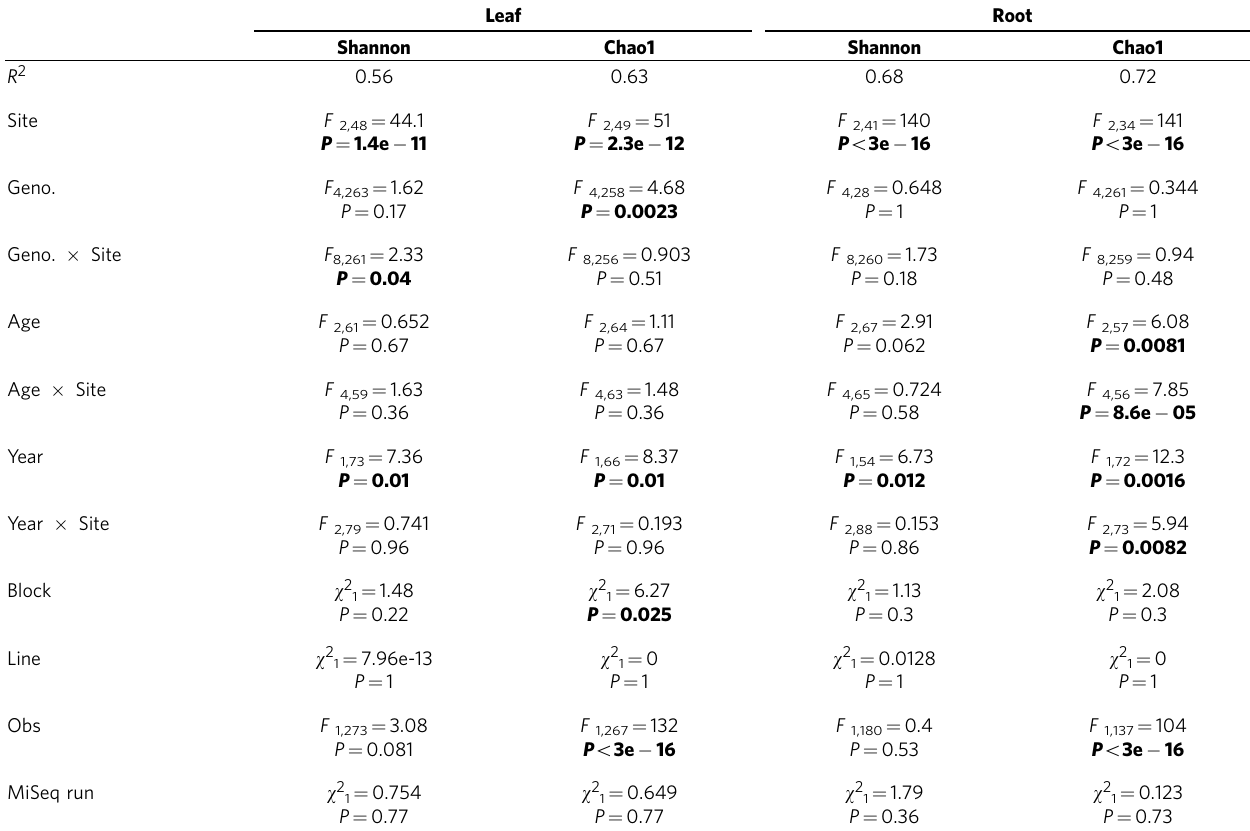
Table 1 | Experimental factors predicting a -diversity of leaf- and root- associated bacterial communities.